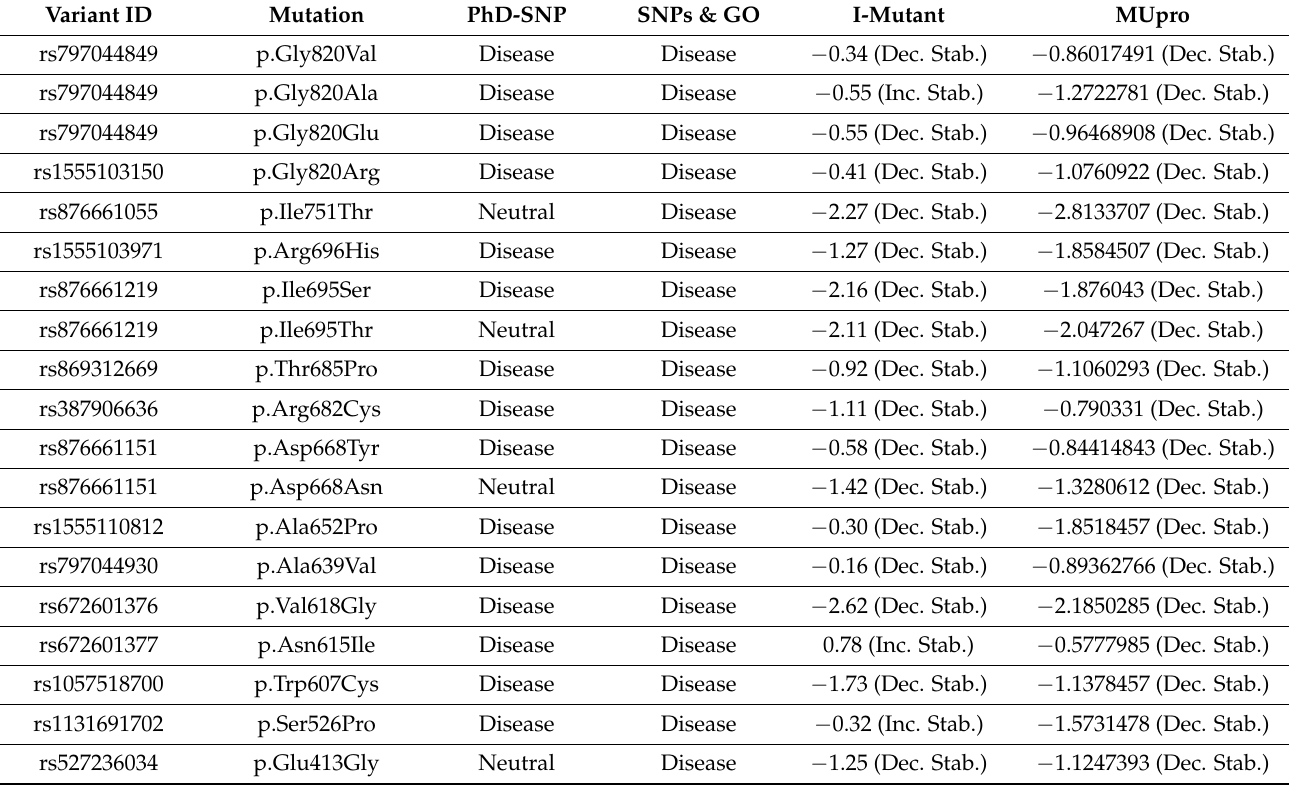
Table 2. Disease association of the SNPs as predicted by PhD-SNP, SNPs & GO, I-Mutant, and MuPro.